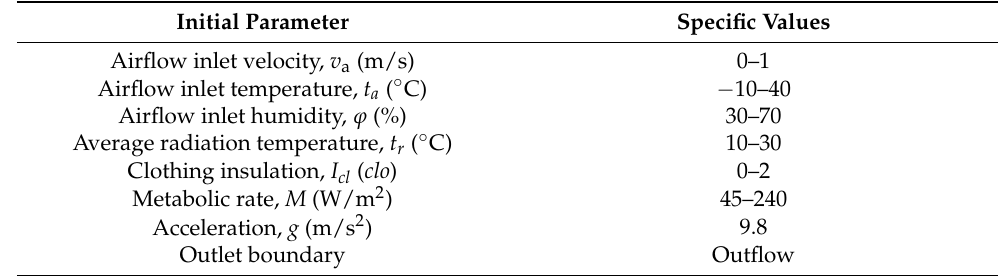
Table 5. Boundary condition settings for the CFD simulation.